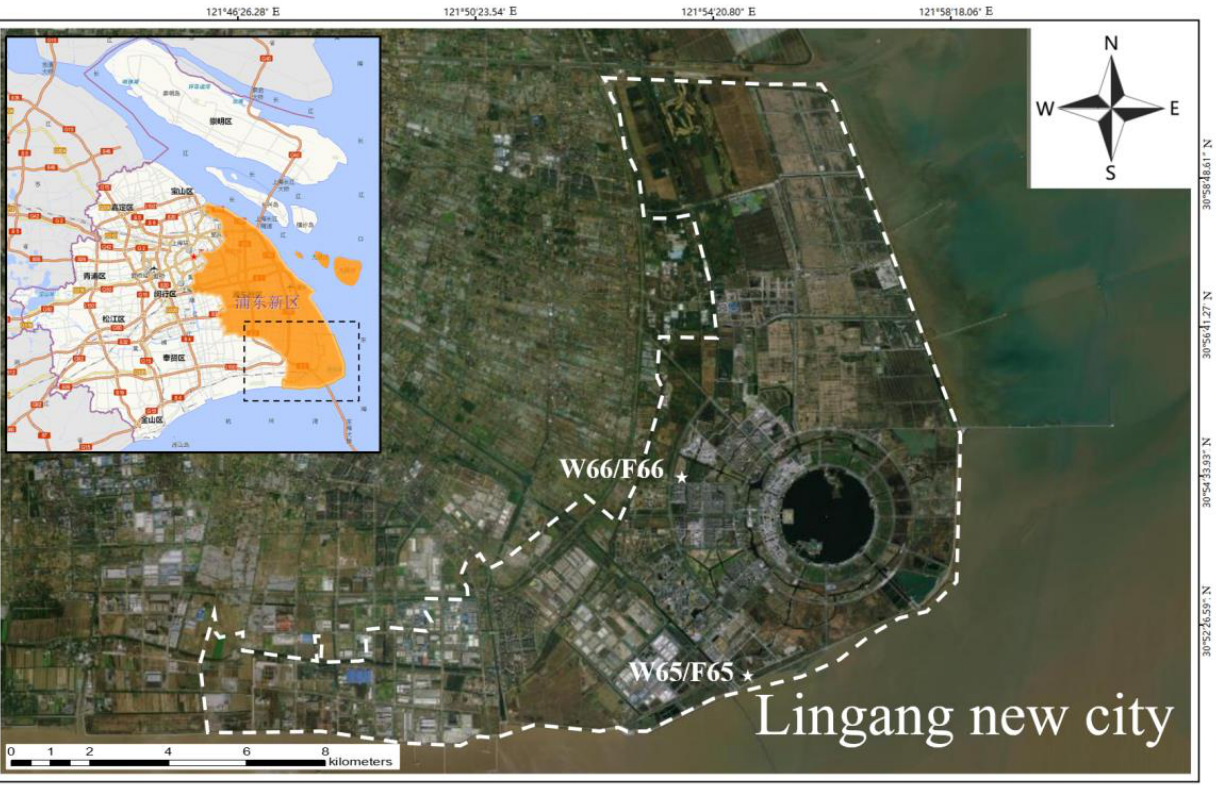
Figure 1. The geographical location of Shanghai Lingang New City and the location of groundwater wells and leveling monitoring points (marked with asterisk).